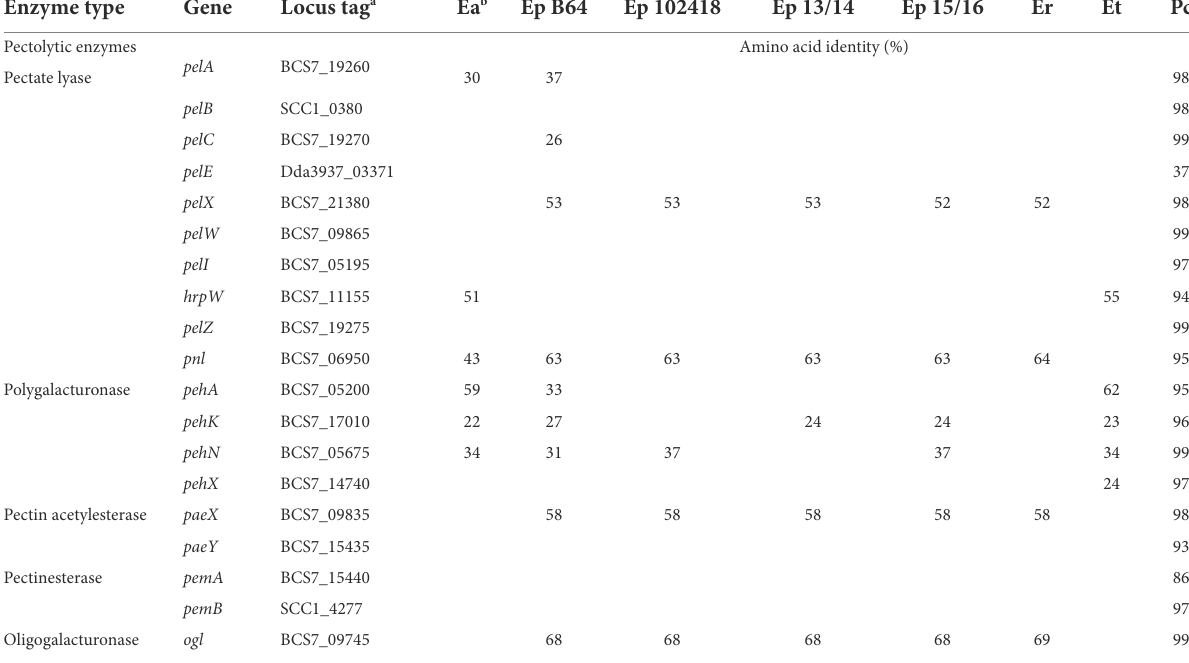
TABLE 4 Pectolytic enzymes among soft rot pathogens. Enzyme type Pectolytic